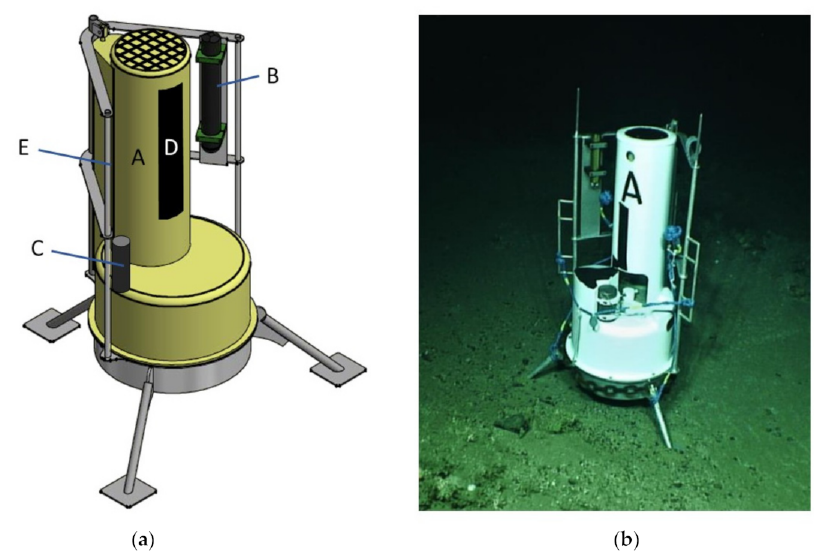
Figure 1. ( a ) Schematic drawing of a Little MonSta and ( b ) deployed with an additional weighted chain on the seabed at 685 m water depth in the Porcupine Bank Canyon. Labeled instruments in the left schematic include: A—Technicap PPS 4/3–24S sediment trap; B—Nortek Aquadopp ADCP profiler; C—Sonardyne homing beacon; D—nylon strip settlement plate; E—ROV manipulator arms